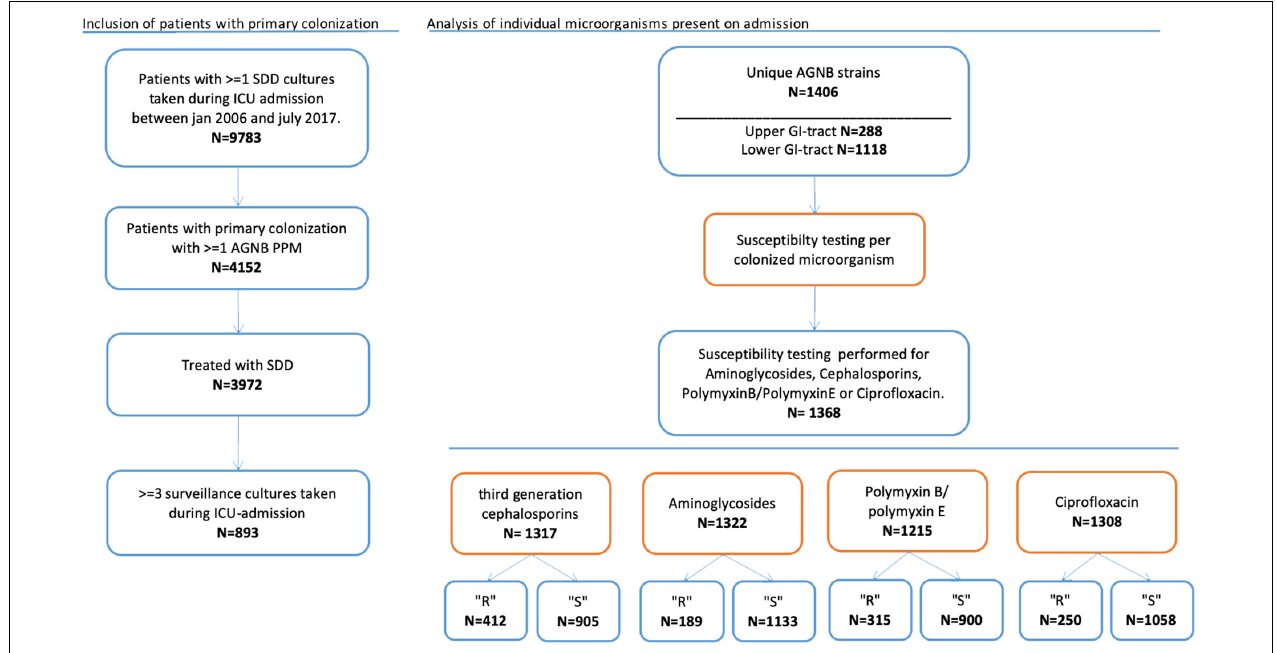
FIGURE 1 | Flowchart of patients and study